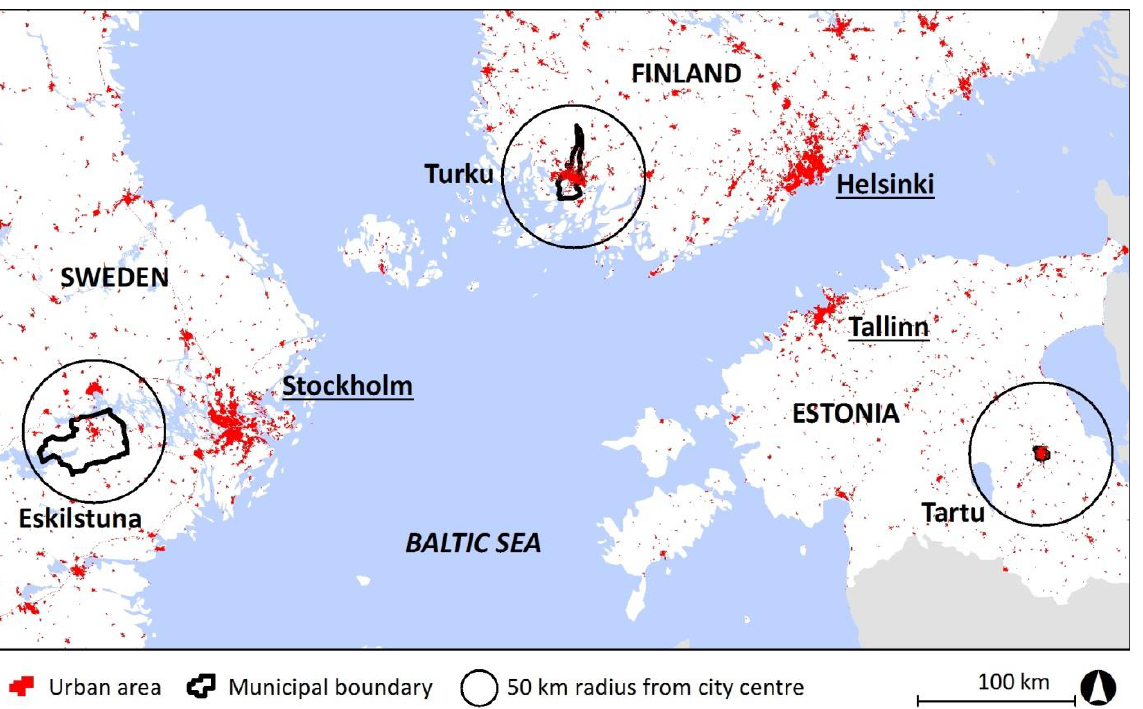
Figure 1. Urban areas in Northern Europe and the three case study cities. Source: European Environment Agency,